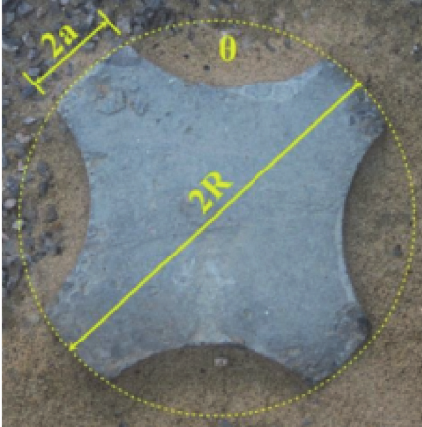
Figure 1: Cross section of a constructed X -section